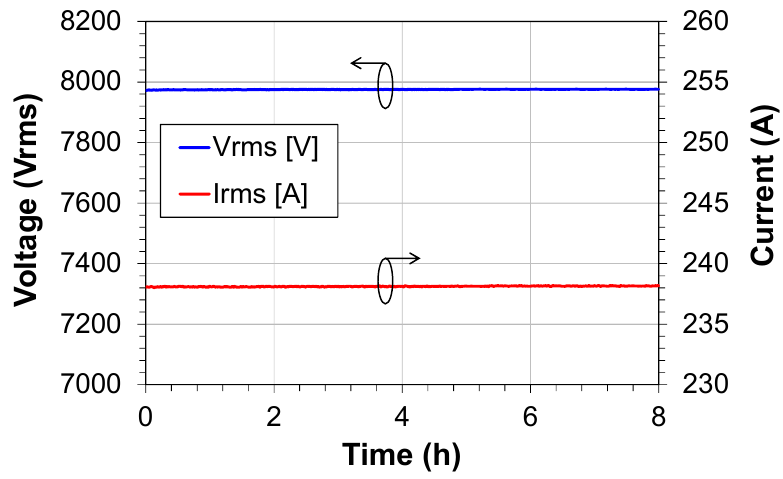
Figure 11. Results of the voltage and current measurements in the short-term test.